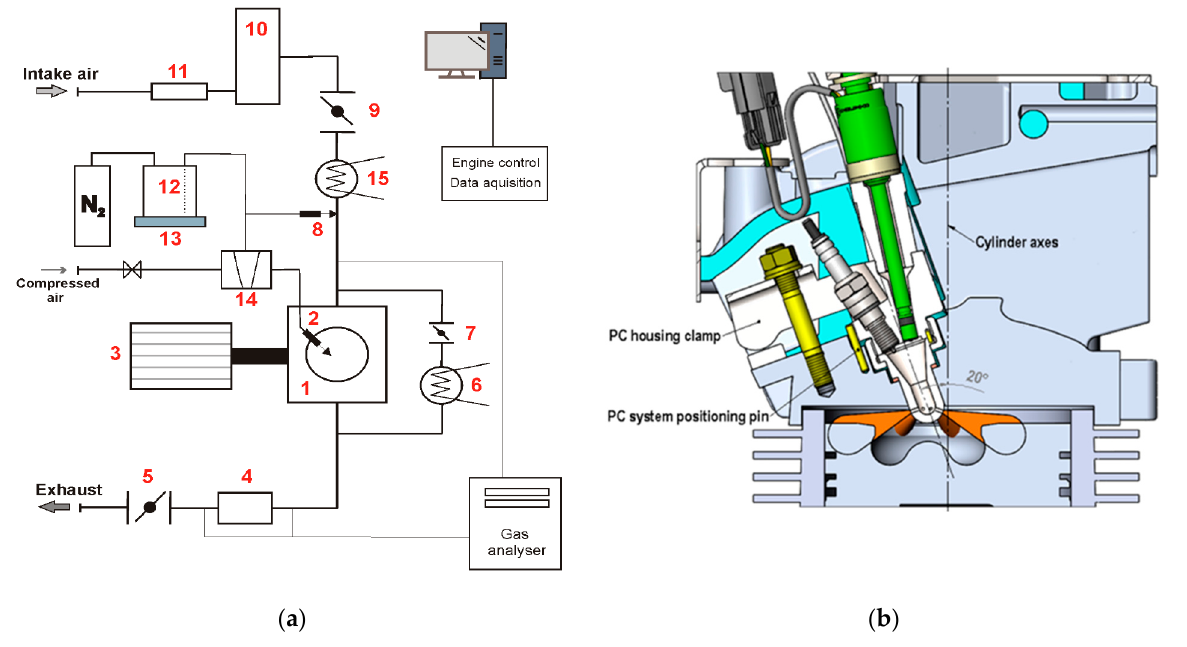
Figure 2. Experimental setup: ( a ) layout of the experimental setup: (1) IC Engine, (2) Pre-chamber Assembly, (3) AC Dyno, (4) Catalyst, (5) Exhaust pipe valve, (6) EGR cooler, (7) EGR valve, (8) Port fuel injector, (9) Throttle, (10) Air tank, (11) Intake mass flow meter, (12) Fuel tank, (13) Fuel scale, (14)